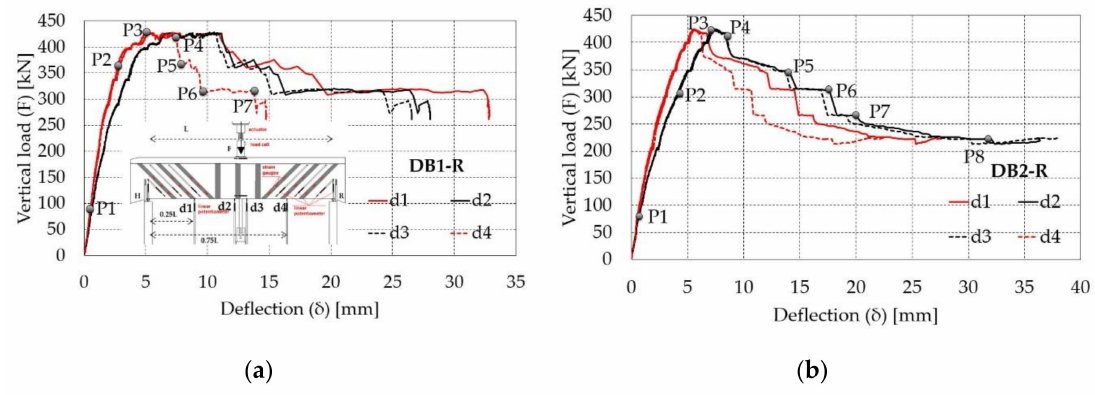
Figure 7. Retrofitted beams: load-deflection responses along the beams DB1-R ( a ) and DB2-R ( b ).